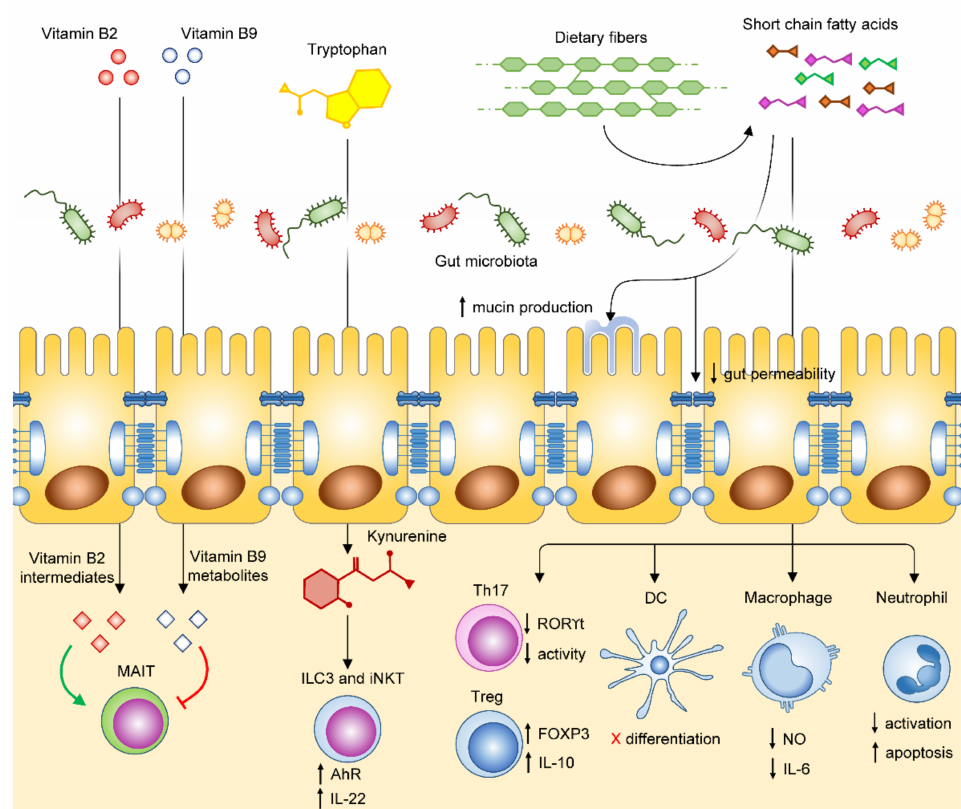
Figure 1. Schematic view of the effects of microbial metabolites on intestinal and immune cells. From left to right: vitamin B2 and B9 metabolites respectively activate and inhibit MAIT cells function; tryptophane metabolite kynurenine activates aryl hydrocarbon receptor (AhR) on iNKT and ILC3 cells and induces IL-22 production; SCFAs produced from microbic metabolism of dietary fibers interact with intestinal epithelial cells and promote mucine production and decrease paracellular permeability; absorbed SCFAs promote FoxP3 and IL-10 expression in regulatory T-cells (Tregs) and decrease ROR ϒ t expression in Th17 lymphocytes, as well as Th17 activity; SCFAs block DC differentiation, decrease production of nitric oxide (NO) and IL-6 in macrophages, and inhibit neu- trophil function and promote their